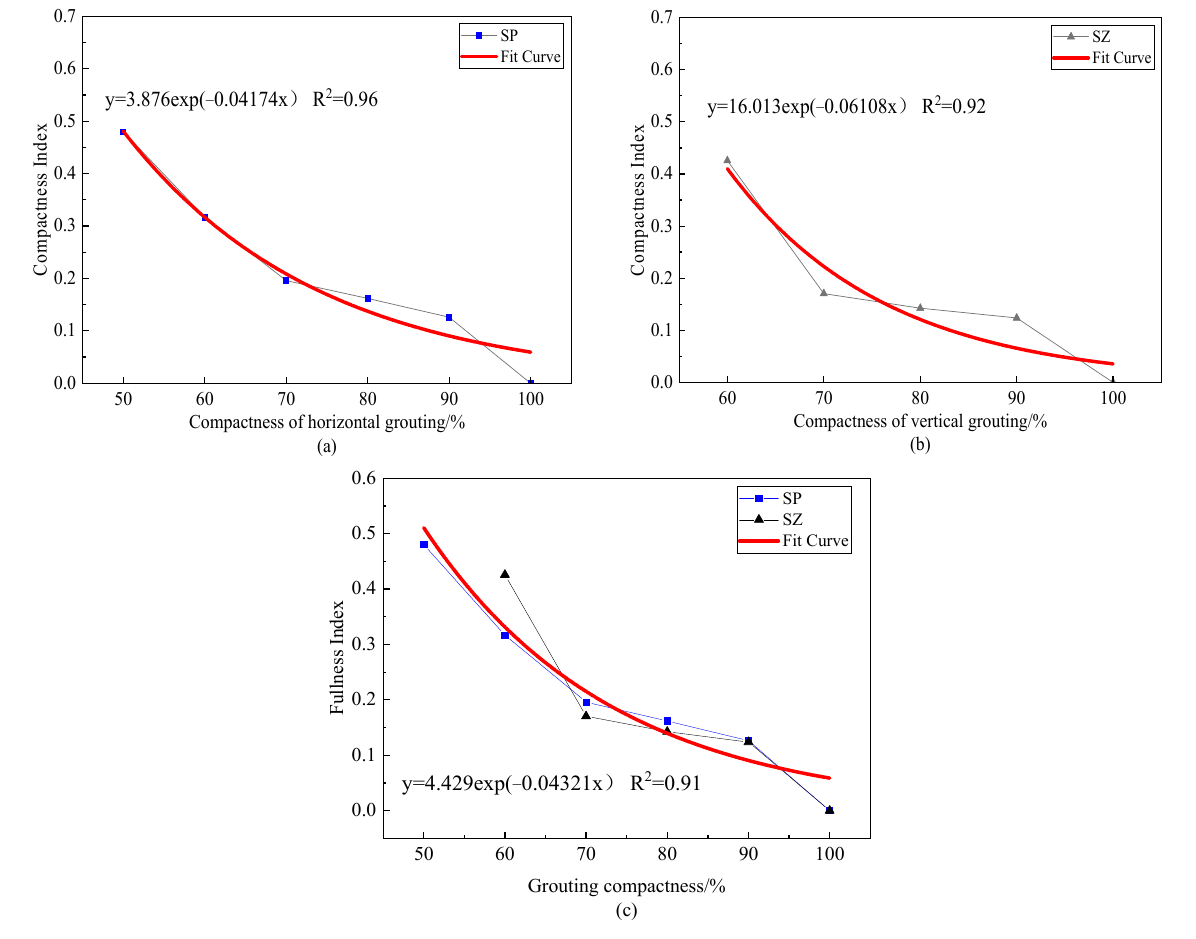
Figure 10. Index map of grout